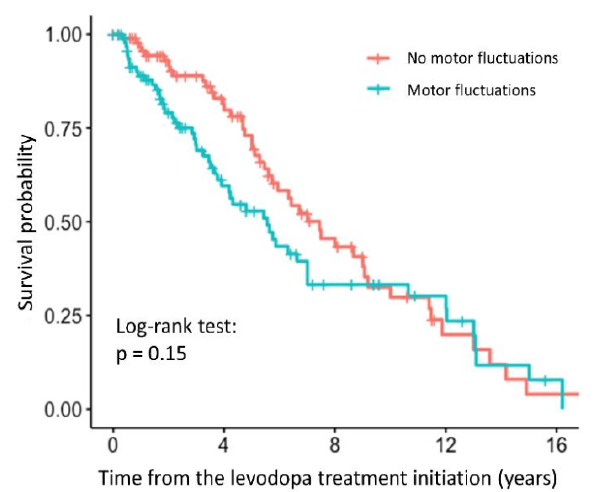
Figure 3. Survival curve for PD patients with and without motor fluctuations after levodopa treat- ment